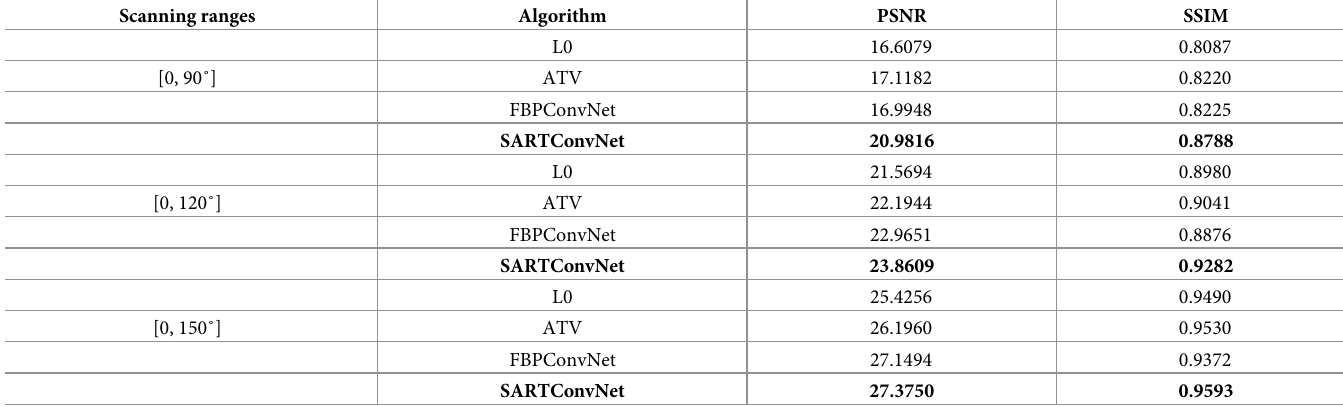
Table 5. Quantitative results associated with different algorithms for the chest image from different angle noise-add projection data. Scanning ranges